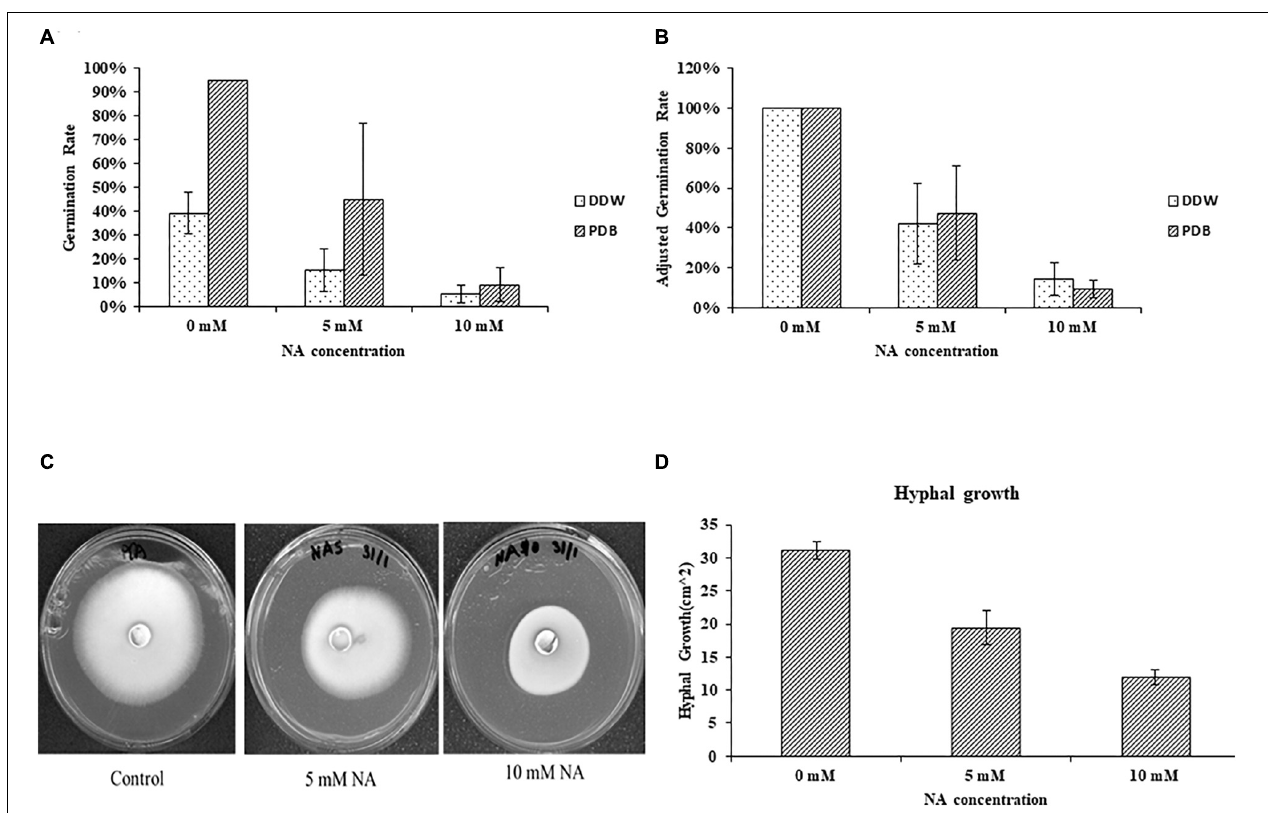
FIGURE 2 | Nicotinaldehyde (NA) has a greater inhibitory effect on germination of F. oxysporum than on hyphal growth. (A,B) Effect of different concentrations of NA (0–10 mM) on conidial germination in PDB and double distilled water (DDW). Conidia were inoculated in PDB and DDW for 14 and 42 h, respectively. Germination was determined as described in Materials and Methods section. Values are mean ± SD and statistically significant with respect to control ( p < 0.05). Vertical lines represent standard error bar. (C) Effect of different concentrations of NA on hyphal growth. Plates were incubated at 28 ◦ C for 5 days and then scanned. (D) Graphical representation of the inhibitory effect of NA on hyphal growth. Values are mean ± SD and statistically significant ( p < 0.05). Vertical lines represent standard error